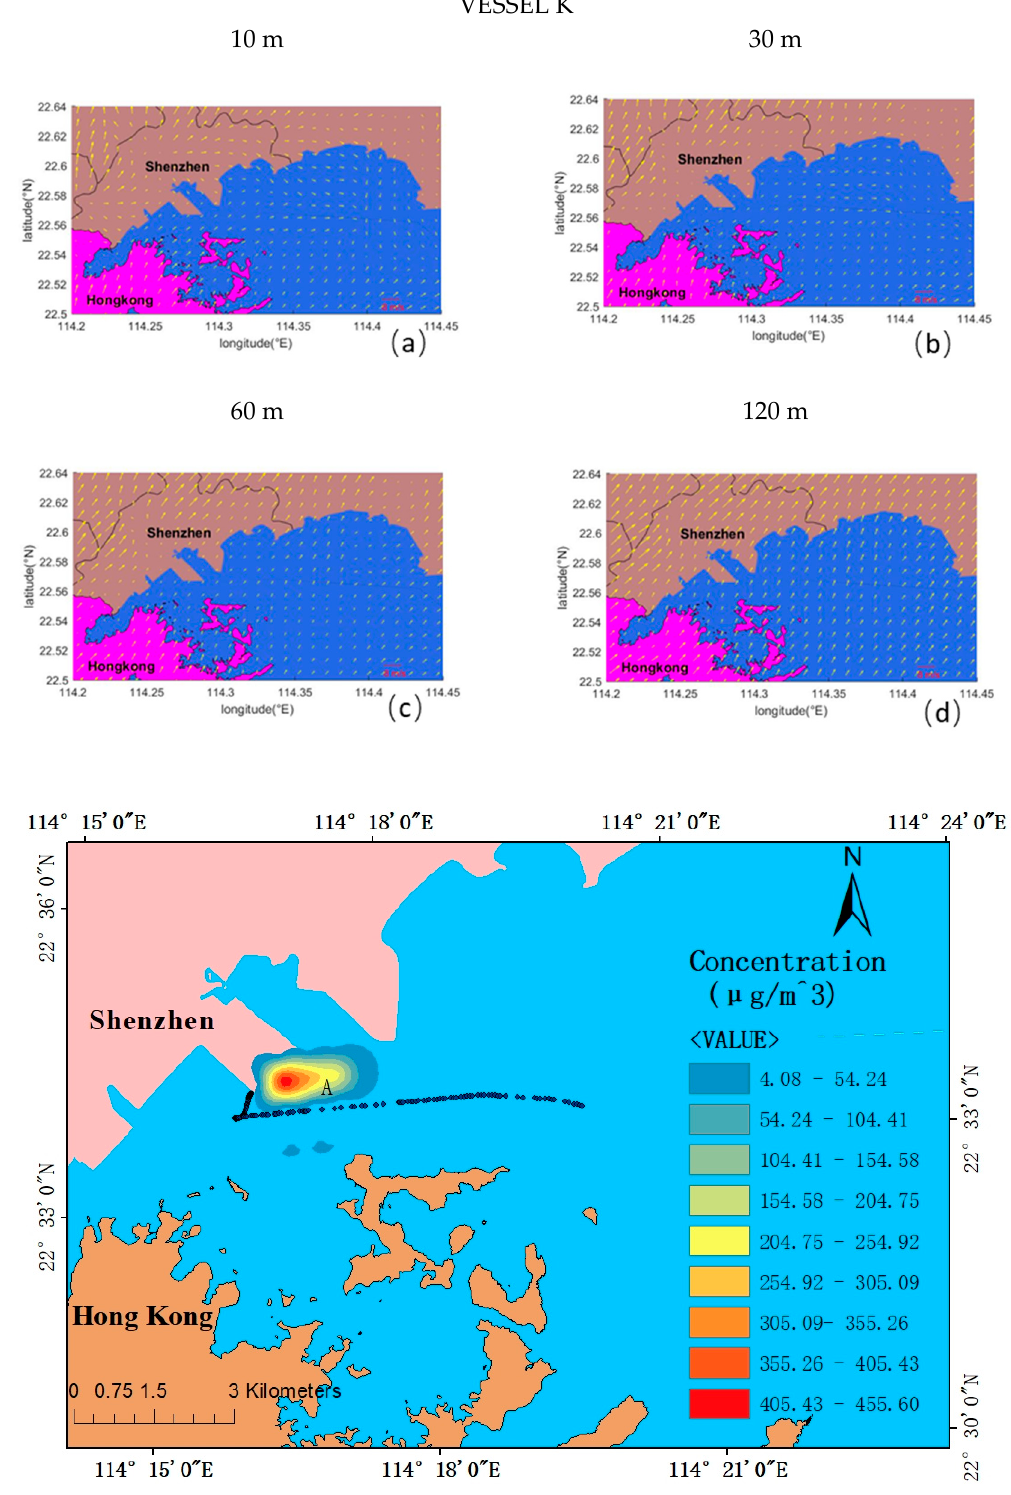
Figure A8. Wind field at different heights at the departure stage of Vessel K and the spatial distribution of the maximum concentration of each simulation grid during the simulation period. ( a ) 10m, ( b ) 30m, ( c ) 60m and ( d ) 120m.